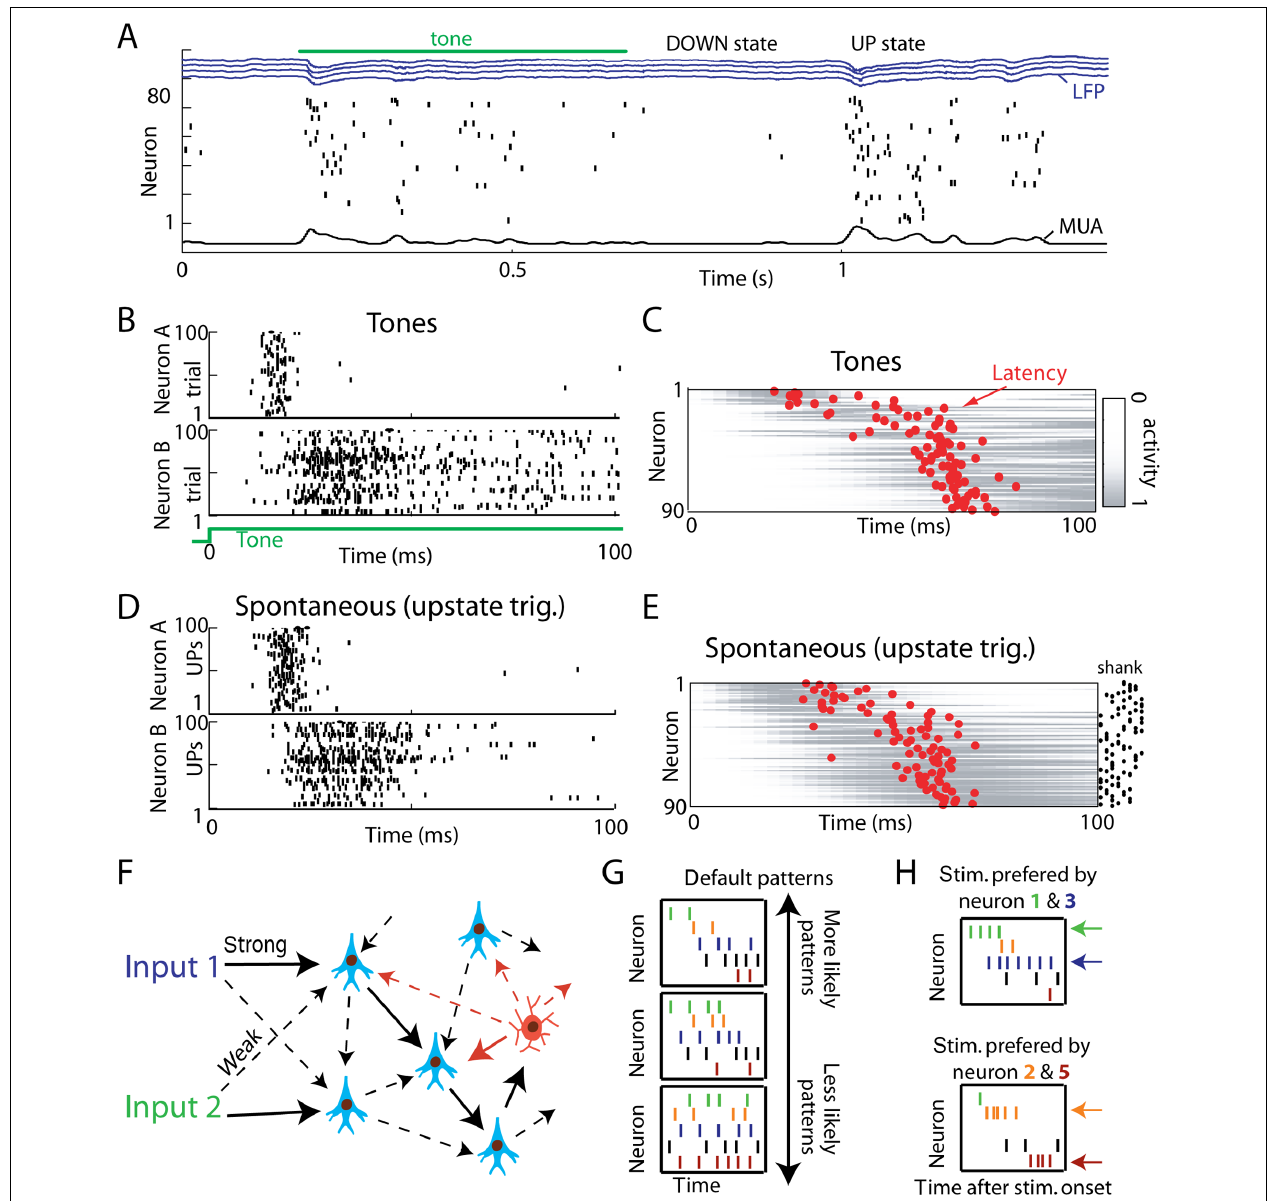
FIGURE 2 | Spontaneous UP states initiate sequential patterns homologous to evoked responses. (A) Representative raw data plot showing a tone response and spontaneous firing event. DOWN states of complete silence alternate with UP states of generalized activity. Neurons are ordered vertically by the mean latency over all stimuli, to illustrate sequential spread of activity. Blue traces show local field potentials (LFPs) from four separate recording shanks; at bottom is the multiunit firing rate (MUA). (B) Raster plots showing spike times for two representative neurons to repeated presentations of a pure tone stimulus. (C) Average activity of 90 simultaneously recorded neurons to tone stimuli. Gray bars show pseudocolor representations of each neuron’s perievent time histogram normalized between 0 and 1; red dots denote each neuron’s latency in